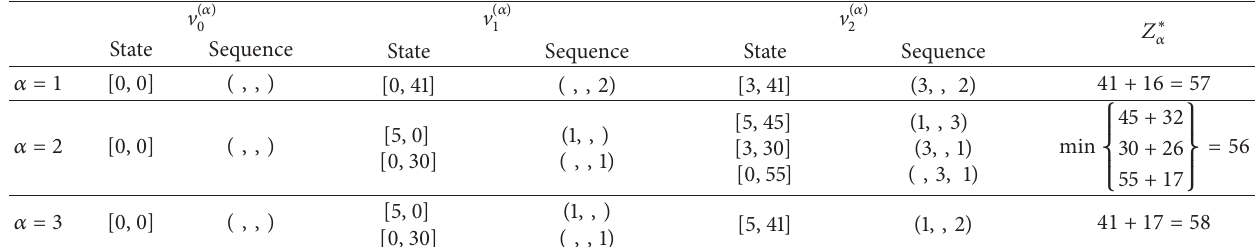
Table 5: Procedure of DP algorithm in Example